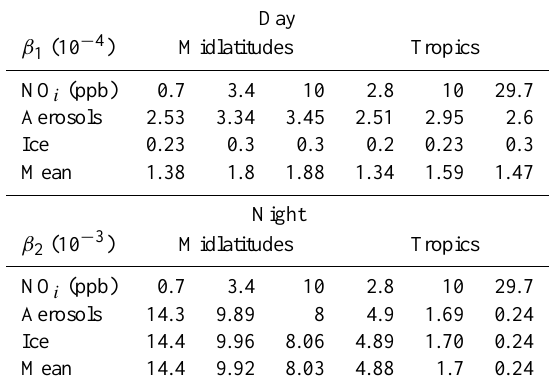
Table 4. The fractions of NO x conversion into HNO 3 within the plume ( β 1 and β 2 ) in the midlatitudes and tropics depending on the initial NO mixing ratio injected by lightning emissions (NO i , ppb) and on particles for day (upper part of table) and night conditions (bottom part of